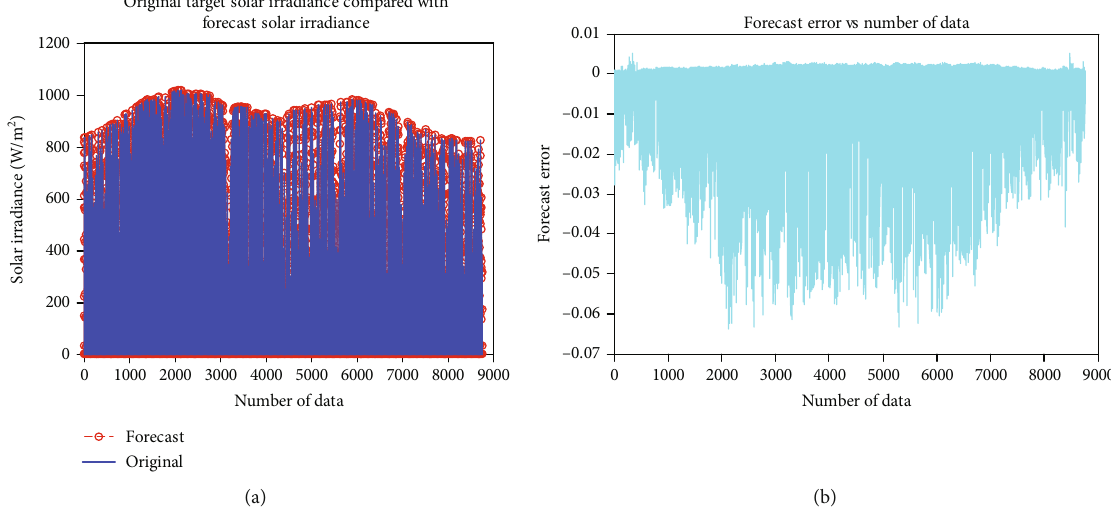
Figure 20: (a) CMMLPNN-based forecasting model original target compared to forecast solar irradiance. (b) CMMLPNN-based forecasting model forecasting error vs. the number of data